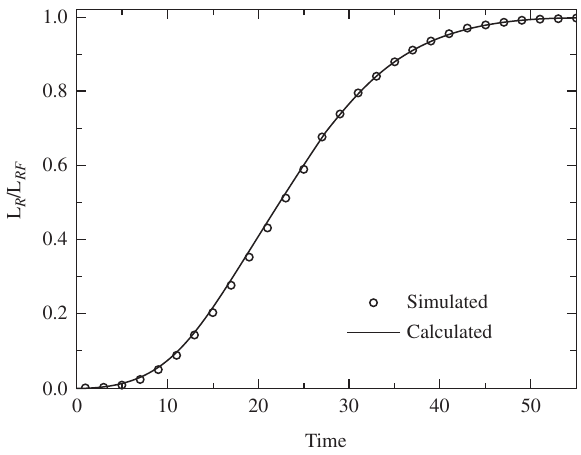
Figure 5. Length of the interface between transformed and transformed region per unit of area, L / L , against time. Simulation results are in agreement with R RF those calculated from the kinetics of a single grain, Equation 21.